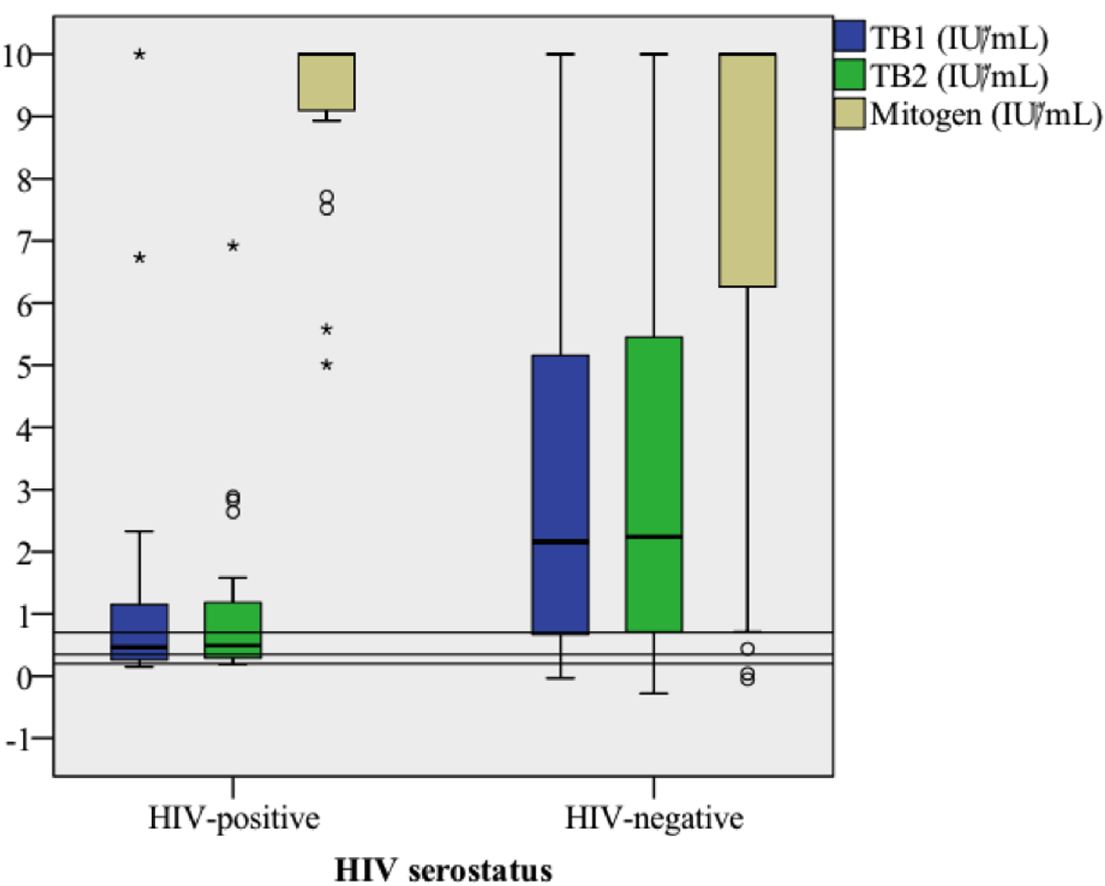
Fig 2. Box-plot of IFN- γ release from TB1 and TB2 antigen formulations- and mitogen stimulation compared by HIV-serostatus. HIV-positive (n = 22) and HIV-negative (n = 285) study subjects with IFN- γ (cid:21) 0.20 IU/ml in at least one TB antigen formulation were included. Horizontal lines represent borders of the borderline zone (0.20 and 0.70 IU/ml) and the conventional cut-off (0.35 IU/ml).